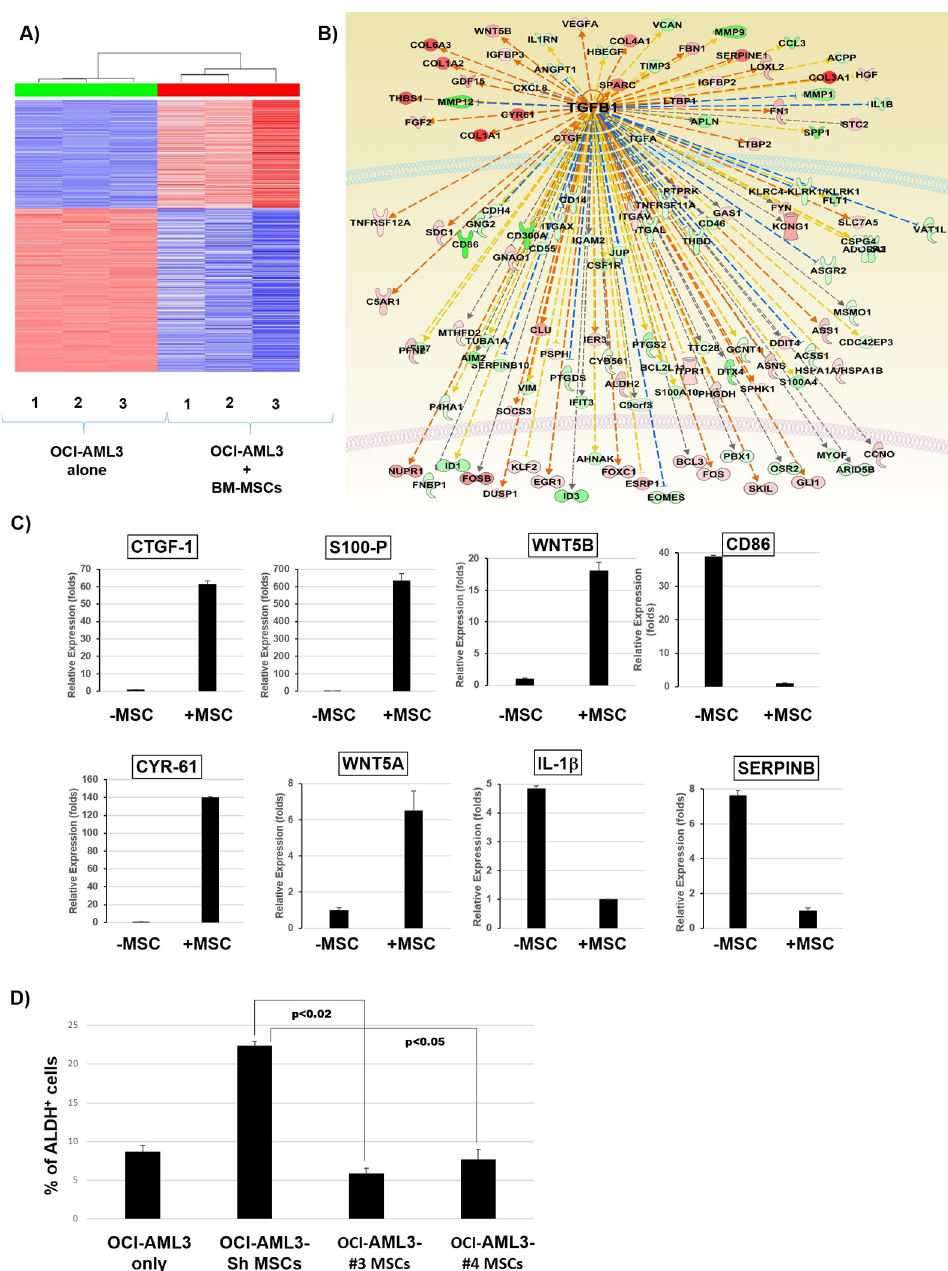
Fig 3. Activation of TGF- β 1 gene signature in OCI-AML3 cells co-cultured with BM-MSCs. (A, B) OCI-AML3 cells were cultured with or without BM-MSC cells for 3 days. OCI-AML3 cells were FACS sorted to separate them from BM-MSCs and the gene expression analysis was performed by RNA sequencing. Samples were sequenced on the HiSeq Sequencing System. Sequence reads were mapped to human genomics (build hg19) with bowtie2 aligner using RSEM software. R software was used to compare the differential expression between MSC co-culture samples and OCI-AML3 controls. Genes with adjusted p values less than 0.05 and absolute fold changes larger than 2 were considered significant. Analysis of differentially expressed genes using the Ingenuity 1 pathway analysis tool revealed activation of a TGF- β 1-associated gene signature. (C) Real-time PCR analysis was performed to analyze the expressions of the indicated genes that are differentially regulated by TGF- β 1 in OCI-AML3 cells co-cultured with BM-MSCs compared to OCI-AML3 controls. (D) TGF- β 1 knockdown MSCs were generated by transfection with plasmid-containing lentiviruses and co-cultured with OCI-AML3 cells for 3 days. ALDH activity was measured by flow cytometry in OCI-AML3 cells cultured with TGF- β 1 knockdown MSCs compared to OCI-AML3 cells cultured alone or with control BM-MSCs. Data are plotted as mean values with error bars representing standard error. For C , the Mann-Whitney U test or Student’s t test was used. For D , one-way ANOVA with Tukey’s HSD post-hoc test was used.